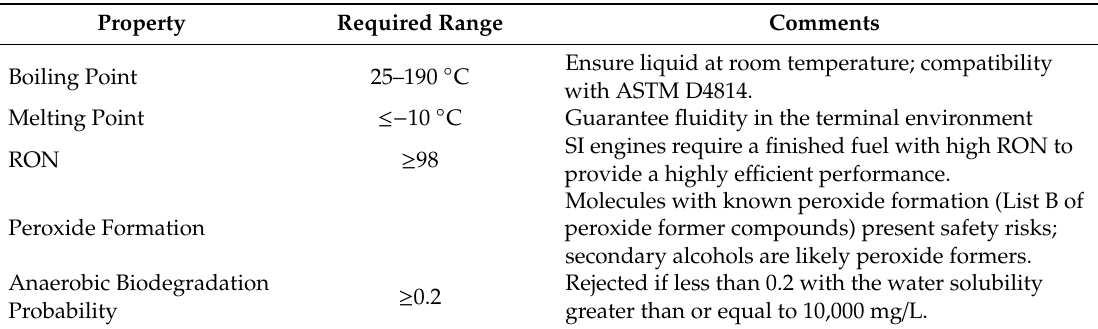
Table 1. Fuel property values used in the first-stage